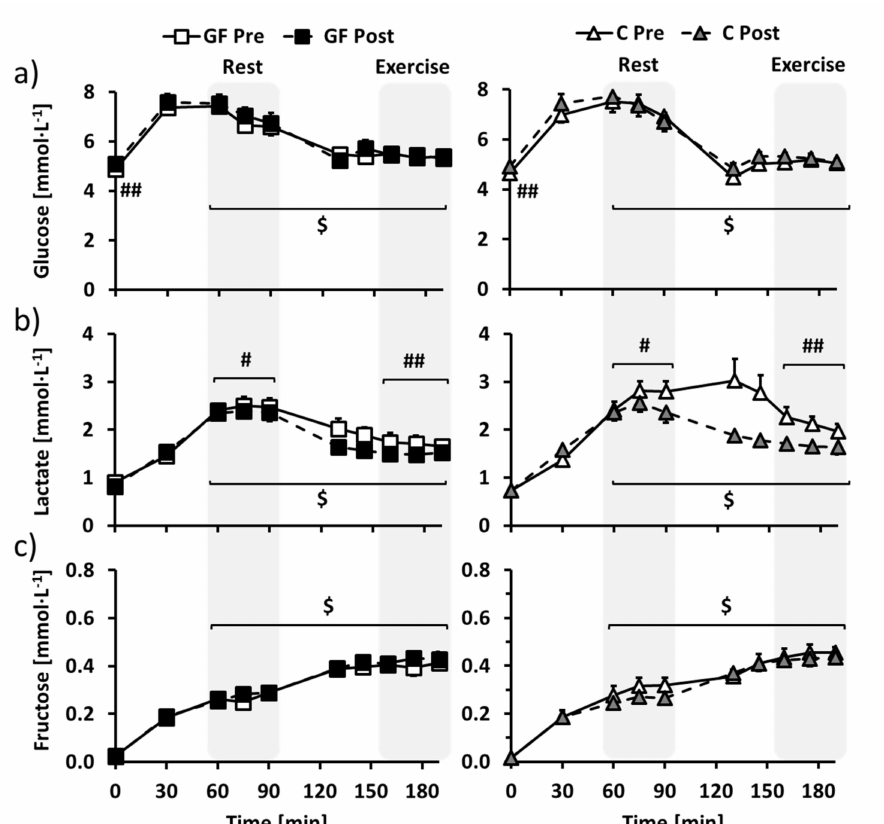
Figure 3. Changes over time of plasma ( a ) glucose, ( b ) lactate and ( c ) fructose concentrations in GF ( left ) and C ( right ) participants during metabolic evaluations. Glucose-fructose drinks were provided both at rest (time = 0–90 min) and during exercise (time = 100–190 min) in all tests. GF pre-training (GF Pre) and C pre-training (C Pre) is indicated in white, GF post-training (GF Post) in black and C post-training (C Post) in grey. Effects of exercise and interventions were compared using a mixed-model analysis. Paired contrasts were used for rest vs. exercise periods (E effect: $: p < 0.01) and pre- vs. post-training (T effect: #: p < 0.05; ##: p < 0.01). Dashed zones: Measures considered for tracer calculations. Mean ± SEM for n = 8 participants in all